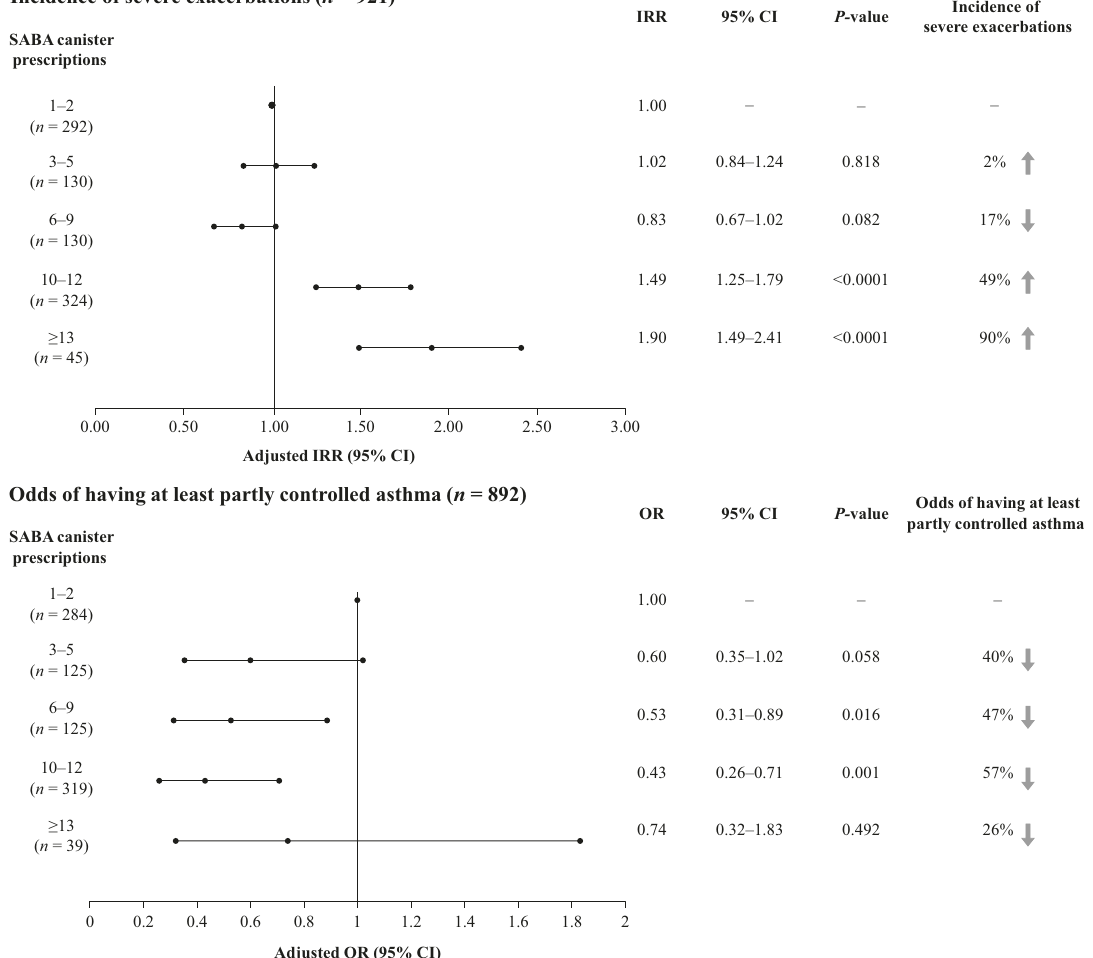
Fig. 3 Association of SABA prescriptions with incidence of severe exacerbations in the 12 months prior to study entry and level of asthma control assessed during the study visit in the SABINA III PCP cohort. Note: ORs were adjusted for age, country, sex, and smoking as pre-speci fi ed covariates; and GINA step by investigator, healthcare insurance, education level, comorbidities, duration of asthma, and BMI as potential confounders. IRRs were adjusted for age, country, sex, and smoking as pre-speci fi ed covariates; and duration of asthma and BMI as potential confounders. BMI body mass index, CI con fi dence interval, GINA Global Initiative for Asthma, IRR incidence rate ratio, OR odds ratio, PCP primary care physician, SABA short-acting β 2 -agonist, SABINA SABA use IN